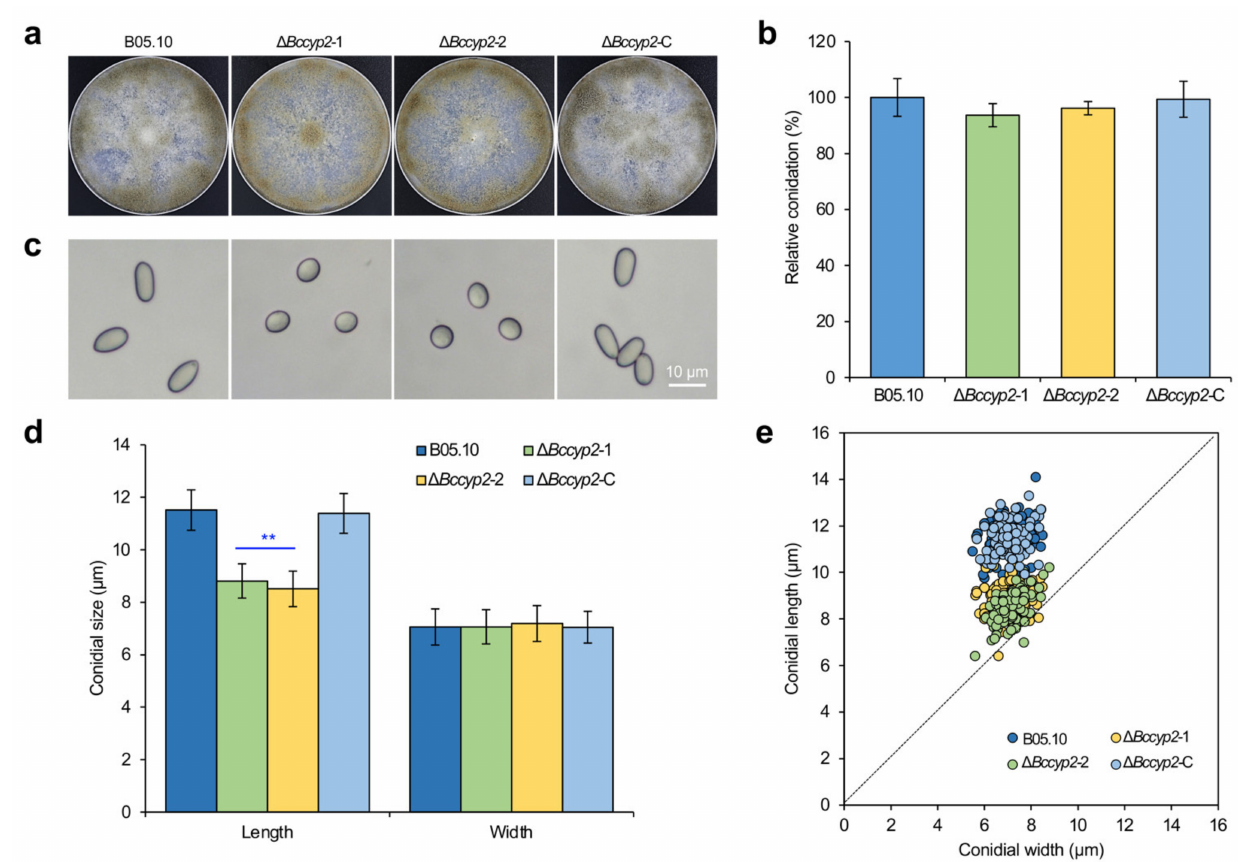
Figure 1. BcCYP2 is required for B. cinerea conidial morphogenesis but dispensable for conidiation. ( a ) Conidiation of the indicated wild-type (WT), ∆ Bccyp2 and complemented strains of B. cinerea on complete medium (CM) plates at 10 days post-inoculation/incubation (dpi). ( b ) Quantification of the relative conidiation of the indicated strains shown in ( a ). ( c ) Alteration of conidial morphology in the ∆ Bccyp2 mutants. ( d ) Quantification of sizes (length and width) of conidia produced by the indicated strains. Conidia were harvested from 10-day old CM plates and conidia (>300) of each strain were measured under a microscope. ( e ) Loss of BcCYP2 increases the number of globose and less elliptical conidia (closer to the dash line). Conidia (>300) of each strain were measured under a microscope in each independent experiment. The representative images are from one of the experiments, three independent experiments were performed and resulted in similar results. Data represent the means ± standard deviations (SD) from three independent experiments with triplicate plates examined for each treatment. **: significance at p <